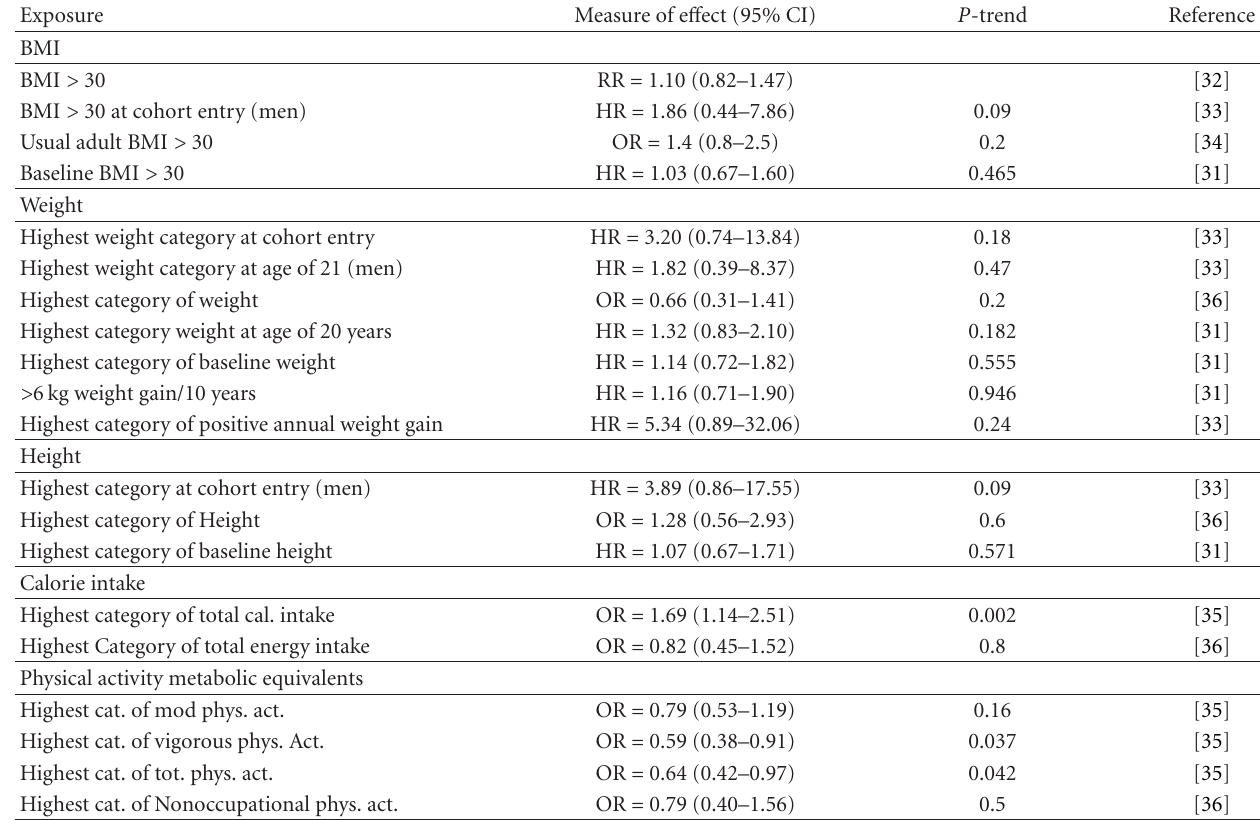
Table 3: Anthropomorphic factors associated with the development of follicular